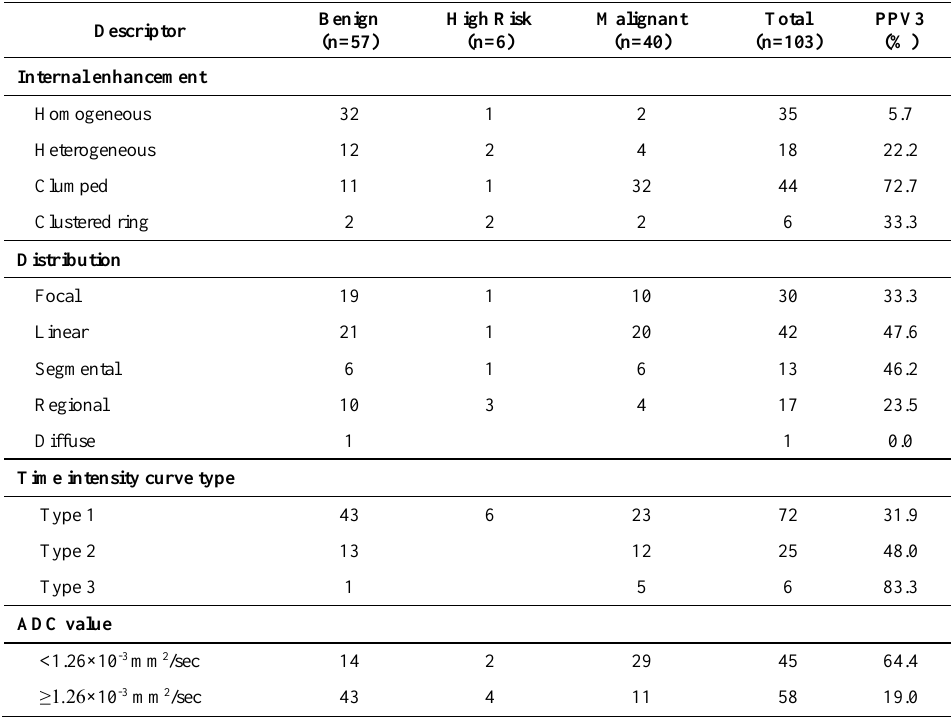
Table 2. Imaging characteristics of 103 non-mass